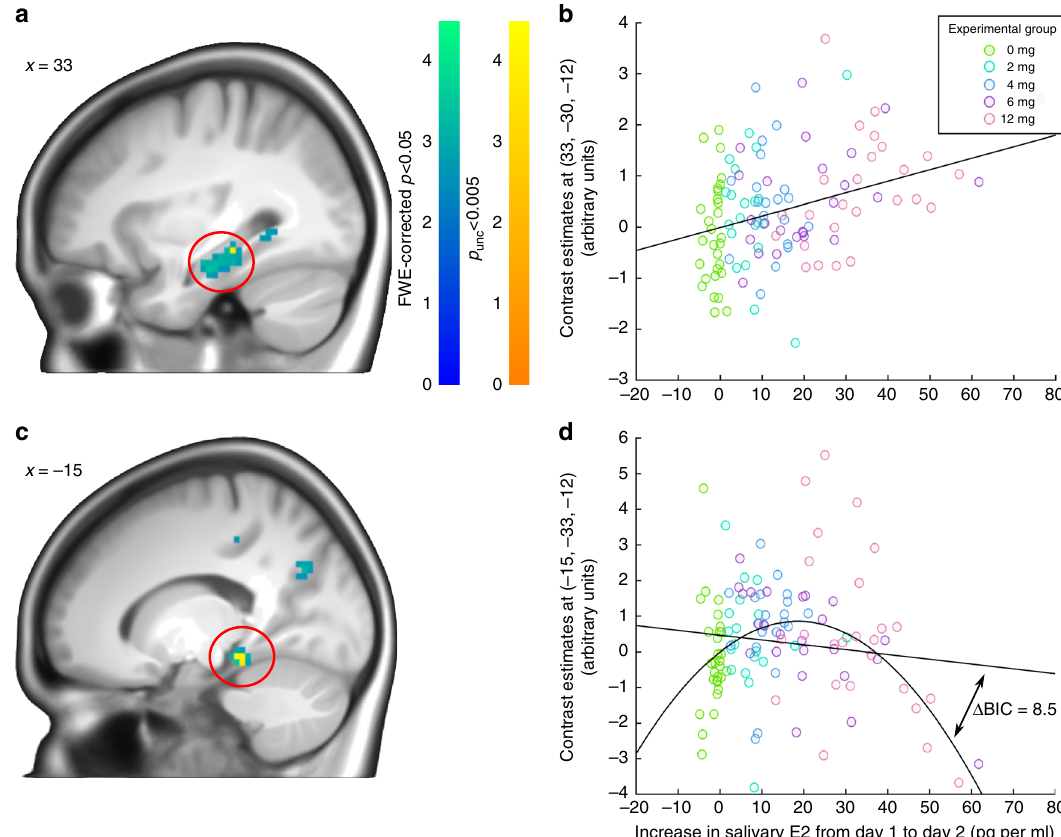
Fig. 5 Relationship between 17-beta-estradiol (E2) increase and the remember >know contrast. a Statistical t-map of the positive linear relationship between salivary Day 1 to Day 2 increase in E2 and the remember > know contrast ( N = 118). Statistical maps are thresholded at FWE-corrected p < .05 (warm color scale) and p unc < .005 (cold color scale) for visualization purposes. A cluster in the right hippocampus showed a positive linear relationship with salivary E2 increase (FWE-corrected p = .043; t -test). b Robust regression analysis between contrast estimates (y-axis) and salivary E2 increase (x-axis) con fi rmed the positive linear relationship. Colors represent experimental groups. c Statistical t-map of the negative quadratic relationship between salivary Day 1 to Day 2 E2 increases and the remember > know contrast. A cluster in the left hippocampus showed an inverted U-shaped relationship with salivary E2 (FWE-corrected p = .006; t -test). d Robust regression analysis between contrast estimates (y-axis) and salivary E2 increase (x-axis) con fi rmed the inverted U-shaped relationship. A Bayesian Information Criterion difference ( Δ BIC) of 8.5 between linear and quadratic models strongly evidences a better model fi t of the quadratic compared to the linear